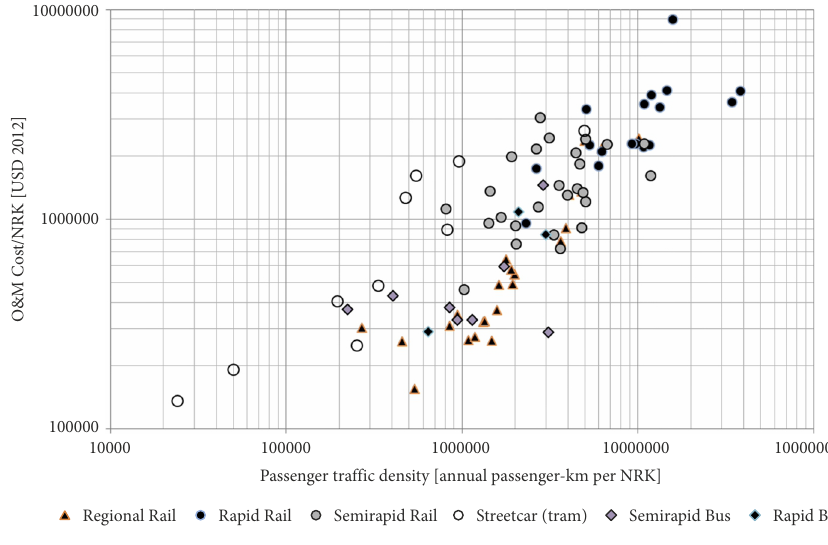
Figure 4. O&M cost per NRK as a function of traffic density